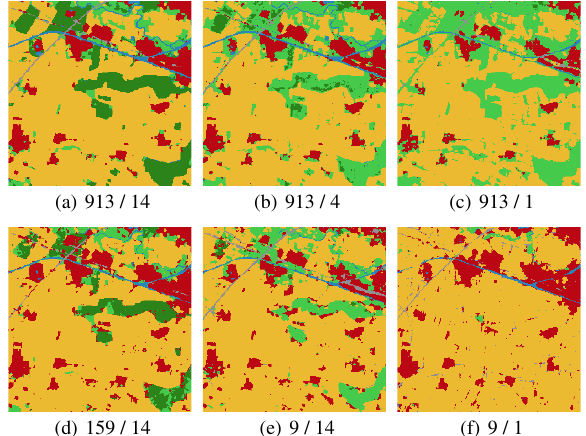
Figure 5. Exemplary prediction results on the tile corresponding to R 1 for different experiments from table 3. Captions: number of tiles / epochs used for training. Colour code: cf. figure 3.